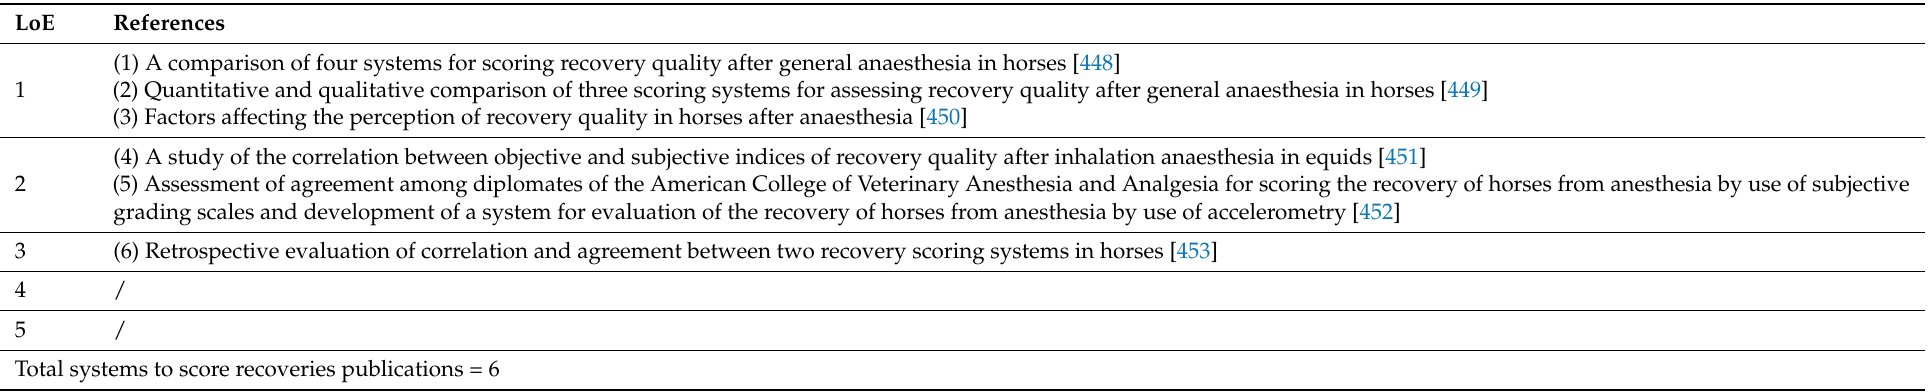
Table 13. Total of publications giving information about “ systems to score recoveries